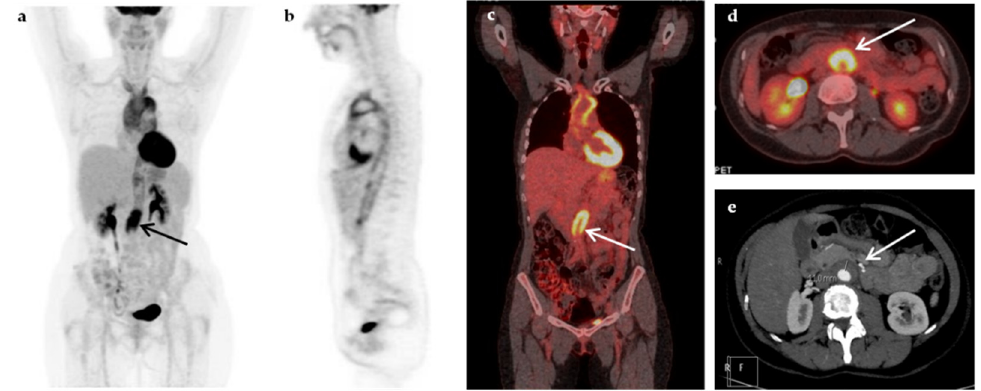
Figure 4. A 52-year-old woman presented with prolonged fever (over 6 months) and increased inflammatory blood markers (ESR 76 mm/h, CRP 9.3 mg/dL). The patient had a medical history of breast cancer seven years ago. Maximum-intensity projection 18 F-FDG-PET ( a ), sagittal 18 F-FDG-PET ( b ), coronal fused 18 F-FDG-PET/CT ( c ), and transaxial fused FDG-PET/CT images at the level of the renal vessels ( d ) demonstrated increased metabolic activity within the wall of the thoracic and abdominal aorta, extending to the subclavian arteries, more intense at the root of the aorta and above the aortic bifurcation (arrows). The findings were compatible with vasculitis of large- and medium-sized arteries, mainly affecting the aorta (panaortitis). Transverse section of the CT angiography at the level of renal vessels ( e ) showed thickening of the aorta wall, more pronounced at the level below the renal vessels (arrow), but with no evidence of narrowing of the aortic lumen. A diagnosis of large vessel vasculitis/Takayasu’s arteritis was made, and fever resolved after treatment with corticosteroids.